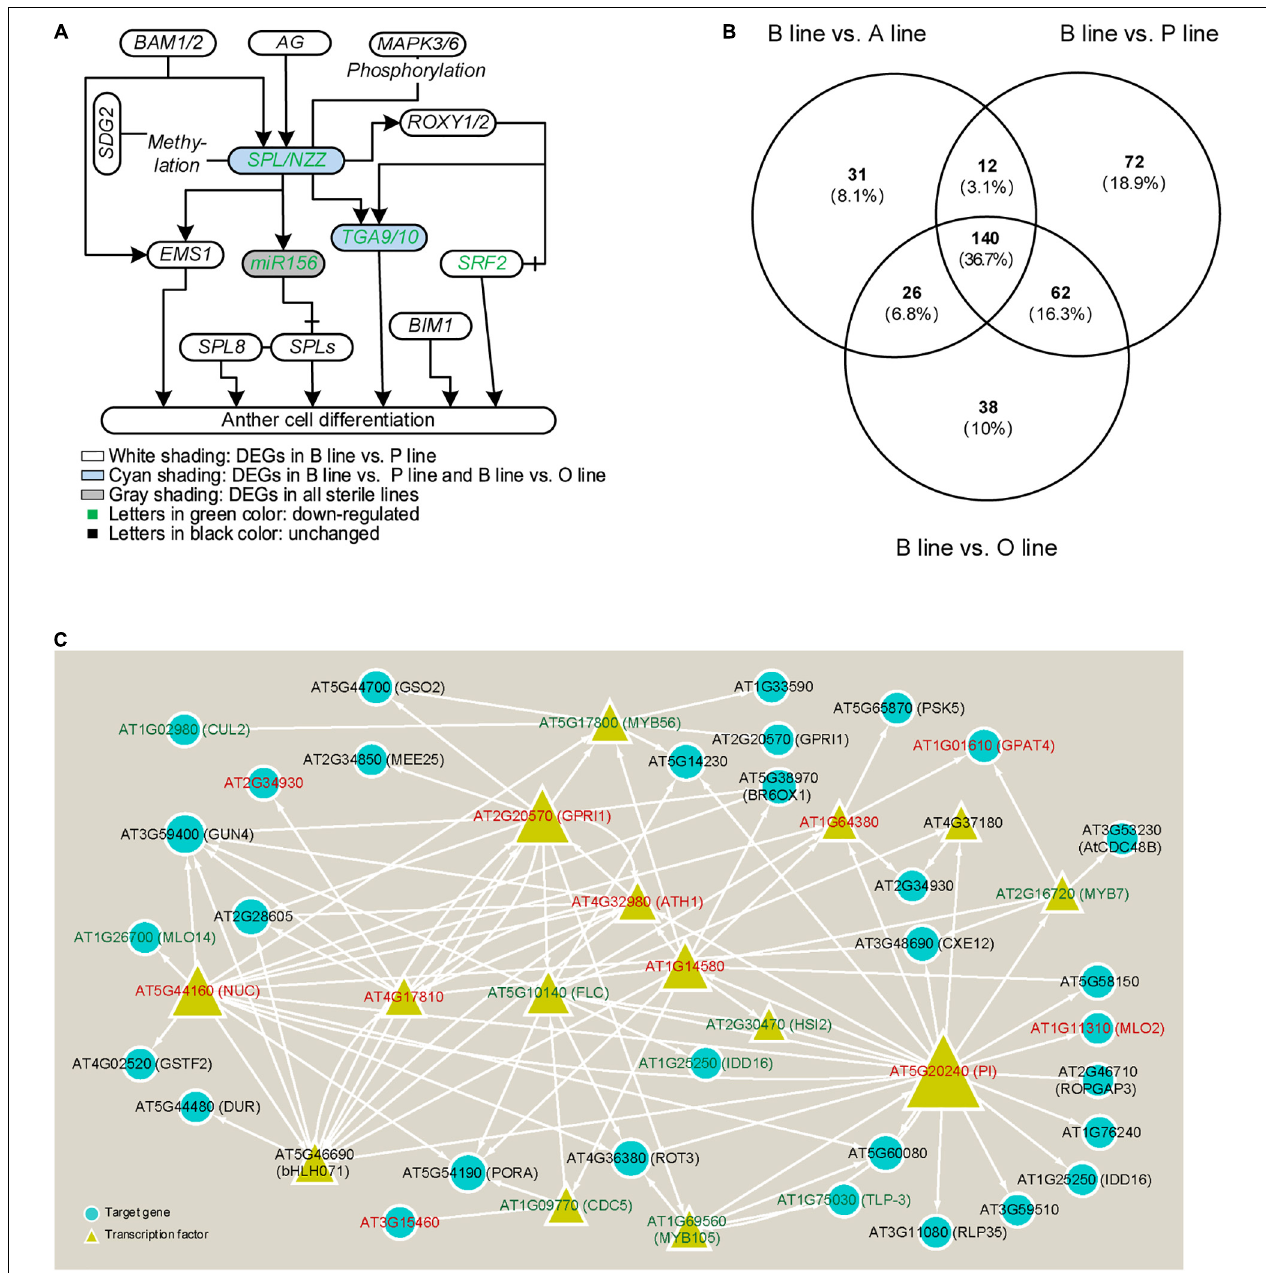
FIGURE 2 | Analysis of genes in anther cell differentiation in three sterile lines of Brassica campestris . (A) Genic network of anther cell differentiation. (B) Venn diagram of differentially expressed genes (DEGs) number involved in cell differentiation in fertile line and sterile lines. (C) Regulatory network of transcription factors annotated to participate in cell differentiation predicted by integrated gene regulatory network (iGRN). Genes in red mean upregulated DEGs, while genes in green represent downregulated DEGs. B line, the fertile line ‘ Bcajh97-01B ’; A line, the sterile line ‘ Bcajh97-01A ’; P line, Polima ( Pol ) cytoplasmic male-sterile (CMS) line ‘ Bcpol97-05A ’; O line, Ogura ( Ogu ) CMS line ‘ Bcogu97-06A ’; BAM1/2, β -amylase 1/2; SDG2, SET domain protein 2; EMS1, excess microsporocytes 1; AG, agamous; SPL/NZZ, sporocyteless/nozzle; SPL8, SQUAMOSA promoter binding protein-like 8; MAPK3/6, mitogen-activated protein kinase 3/6; ROXY1/2, CC-type glutaredoxin 1/2; TGA9/10, TGACG (TGA) motif-binding protein 9/10; BIM1, brassinosteroid insensitive 1 (BRI1)-EMS-suppressor 1 (BES1)-interacting MYC-like protein 2; SRF2, STRUBBELIG-receptor family 2; CUL2, cullin 2; GUN4, genomes uncoupled 4; MLO2/14, mildew resistance locus O; NUC, nutcracker;